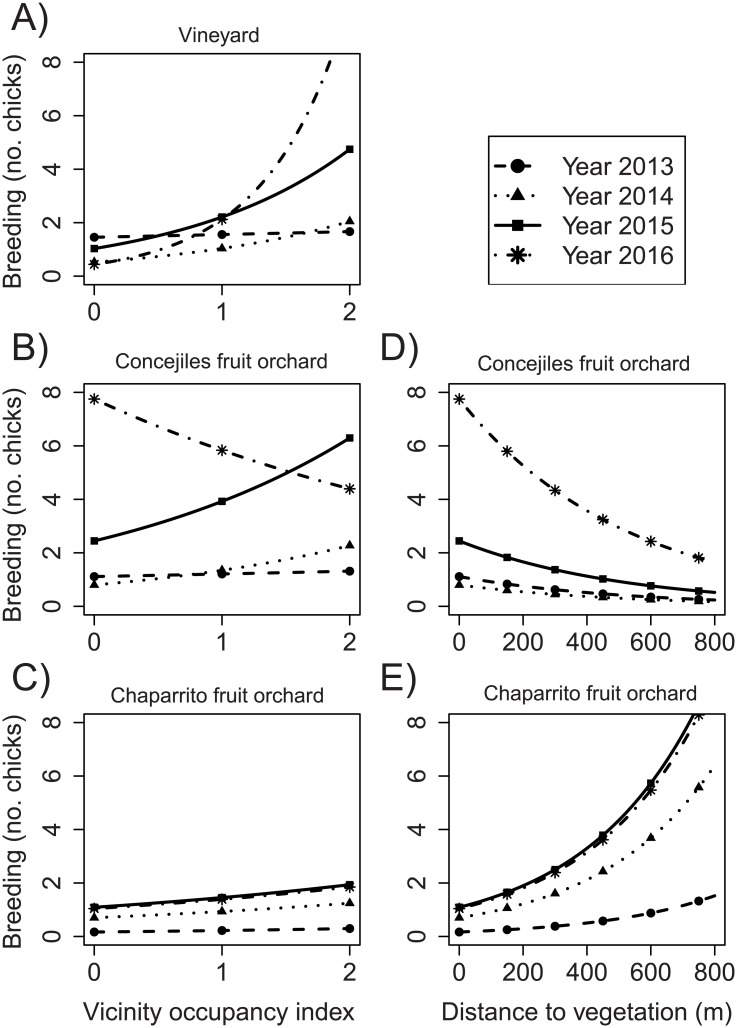
Model-averaged estimated effects of (A-C) occupancy by birds of adjacent nest boxes and (D-E) distance to natural or semi-natural vegetation on bird breeding at the (A) vineyard, (B, D) Concejiles fruit orchard, and (C, E) Chaparrito fruit orchard, across the four years of study.Breeding was measured as the number of laid eggs or chicks/fledglings that were counted at a nest box. A mean distance to natural or semi-natural vegetation of 400 m was used to generate model predictions in panels B and C. Zero occupancy of adjacent nest boxes was used to generate model predictions in panels D and E. Distance to natural or semi-natural vegetation did not apply to the vineyard.